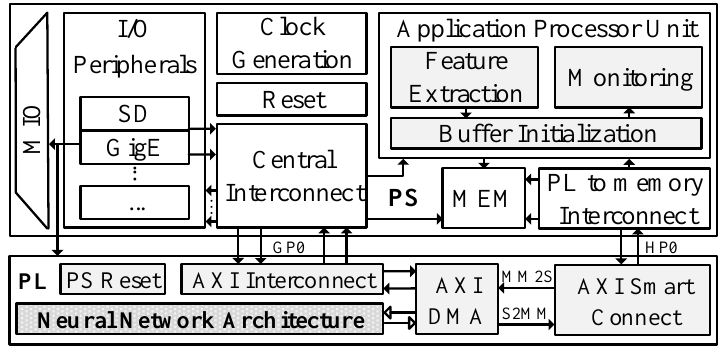
Figure 3. Neural network inference acceleration on Zynq-7000 SoC